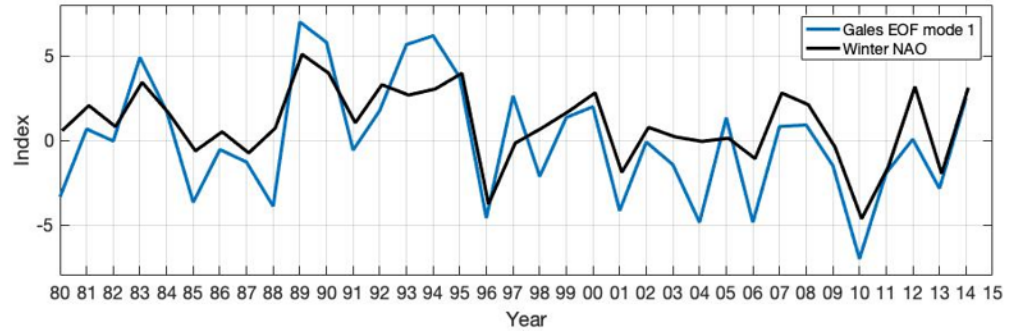
Figure 11. Time series (eigenvalues) of EOF mode 1 eigenvector pattern illustrated in Fig. 10 (blue line), defined as the North Atlantic gale index. NAO index after Hurrell (1995). The winter is defined as the year containing JFM; i.e. for a winter December 2013–March 2014, the year is 2014. The two indices correlate with R = 0 .